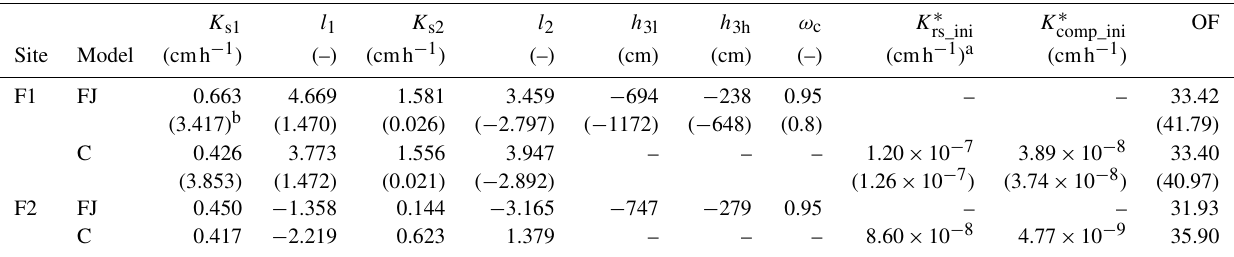
Figure 5. Comparison between observed (black) and simulated (a) soil water content (SWC) and (b) soil water pressure head (SWP) by the Feddes–Jarvis (FJ) and Couvreur (C) models at six soil depths in the sheltered (P1), rainfed (P2), and irrigated (P3) plots of the stony soil (F1) from 11 February to 14 July 2014. Time series of precipitation (Pre) and irrigation (irri) and of the potential daily potential ( T pot ) and actual transpiration ( T act = RWU) that were simulated by the Feddes–Jarvis (FJ) and Couvreur (C) models are given in the panels above the SWC and SWP measurements. Table 4. The saturated hydraulic conductivity ( K s ), model shape parameter ( l ), critical pressure head in the Feddes water stress function ( h 3l , h 3h ), the compensation parameter ( ω c ), and the root system related parameters ( K rs and K comp ) estimated by the Feddes–Jarvis (FJ) and Couvreur (C) models of the stony (F1) and silty (F2) soils and the corresponding objective function (OF)